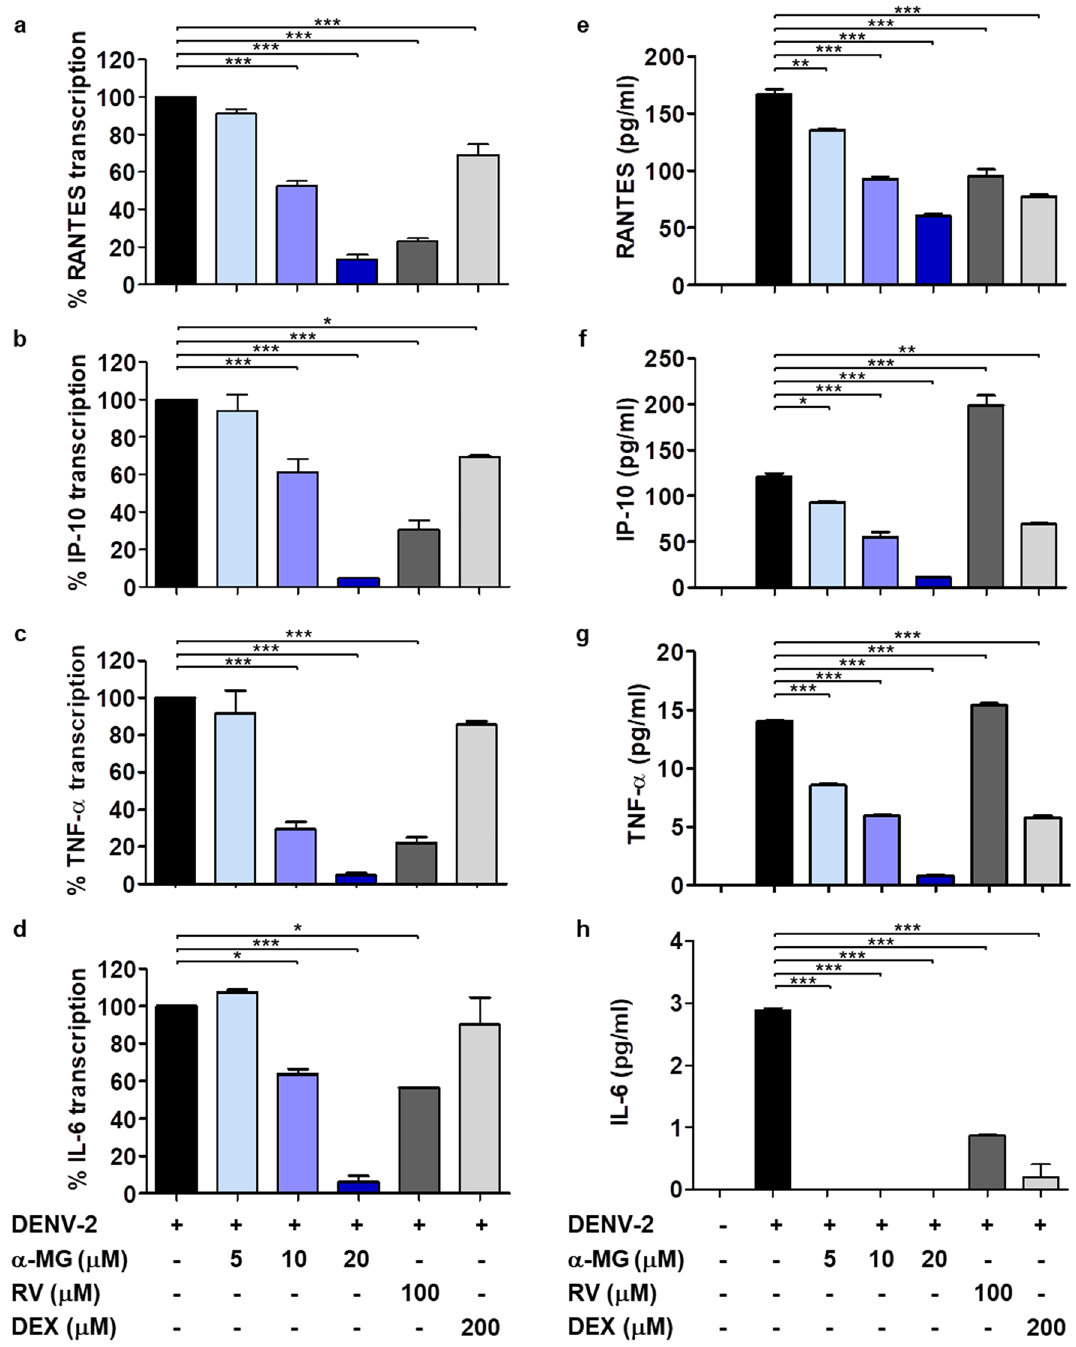
Figure 5. α-MG reduces cytokine/chemokine production in DENV-infected HepG2 cells. HepG2 cells were infected with DENV-2 at a MOI of 5 and treated with either α-MG, RV, DEX, or EtOH solvent at the indicated concentrations for 24 h. ( a – d ) The concentrations of transcription of RANTES, IP-10, TNF-α, and IL-6 in DENV-2-infected HepG2 cells were determined by qRT-PCR using different sets of specific primers. The transcription level of each cytokine/chemokine in untreated DENV-infected cells was defined as 100%. ( e – h ) The culture supernatants were collected and the cytokine/chemokine levels of RANTES, IP-10, TNF-α, and IL-6 were determined by flow cytometry using multiplexed bead-based immunoassays. The results were obtained from three independent experiments, and the results are expressed in mean ± standard deviation. One-way ANOVA followed by Tukey’s HSD test were used to evaluate for differences in cytokine/chemokine production levels as compared to control untreated DENV-infected HepG2 cells (* p < 0.05, ** p < 0.01, *** p <